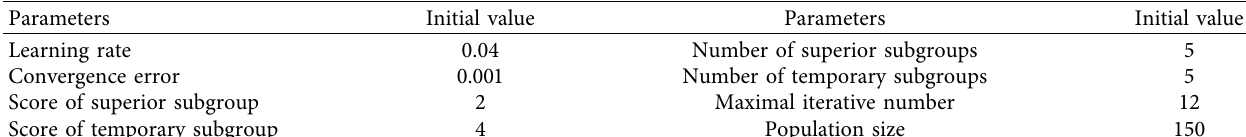
Table 4: Parameters of MEA-BP